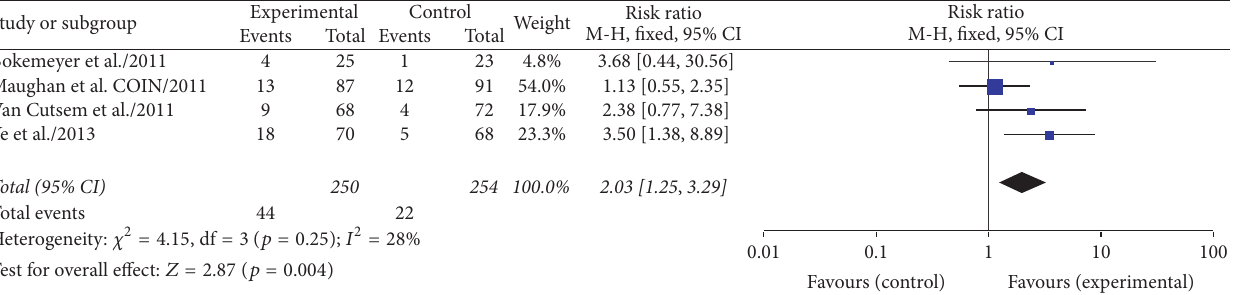
𝜒 2 = 4.15 , df = 3 ( p = 0.25 ); I 2 = 28 % Test for overall effect: Z = 2.87 ( p = 0.004 ) Figure 2: Meta-analysis R0 resection comparing chemotherapy ± cetuximab in patients with liver-limited